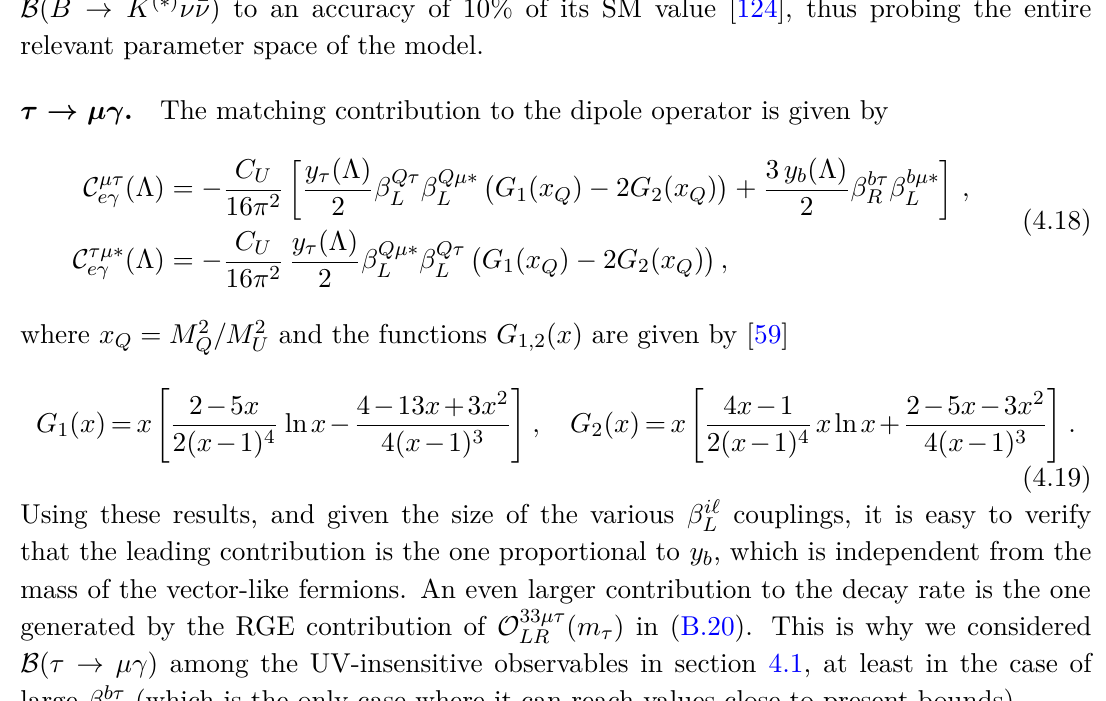
, setting ( L ) ∗ = 0 , M = 4 TeV and g = 3 , and varying the scale of the scalar L d U 4 3 s = [1 , 2 π ] M and M = [0 . 5 , 1] M ranges. As in R U Z 0 U = 0 and β bτ = − 1 R R